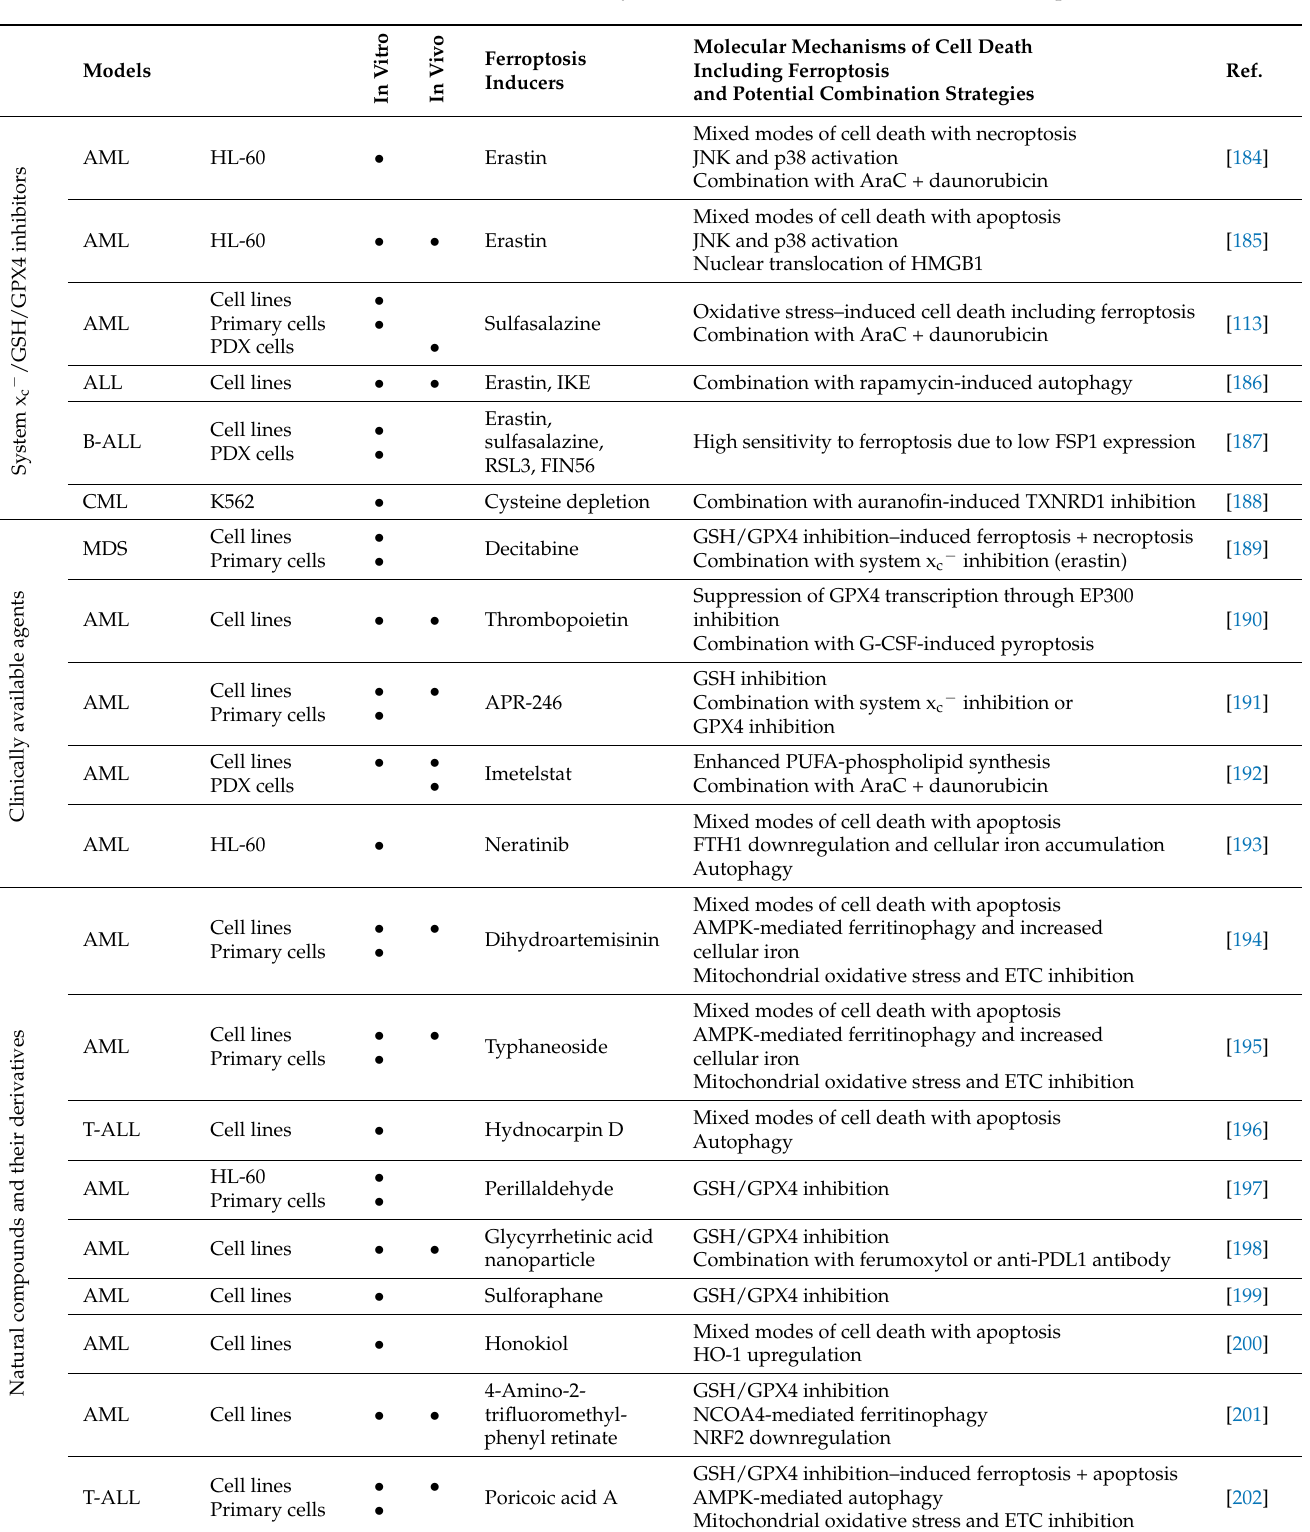
Table 2. Ferroptosis-targeting studies in leukemia. Disease models (cell lines, primary cells, and/or PDX cells), experimental settings for each cell model (in vitro and/or in vivo), ferroptosis inducer(s) studied, mechanism of cell death including ferroptosis and other cell death modes, and potential combinatorial strategies are presented. Abbreviations—PDX, patient-derived xenograft; TXNRD1, thioredoxin reductase 1; TKI, tyrosine kinase inhibitor; ETC, electron transport chain. Molecular Mechanisms of Cell Death Ferroptosis Including Ferroptosis Inducers and Potential Combination Strategies